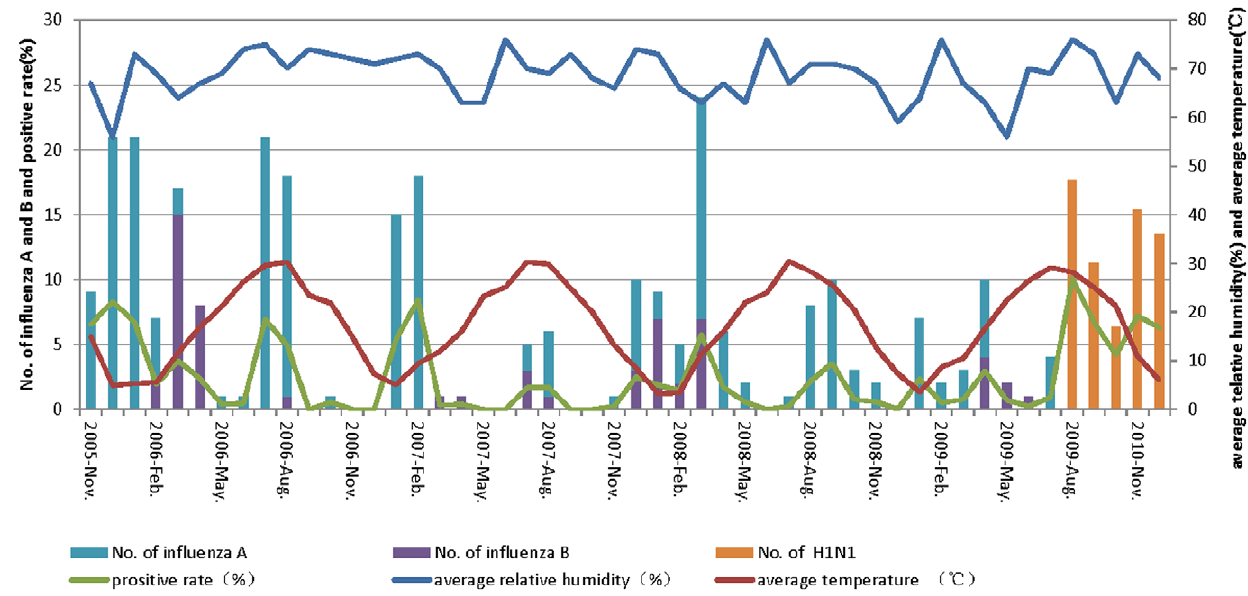
Figure 1. Monthly distribution of number of influenza cases, positive rate, precipitation and mean temperature in Suzhou from Nov 2005 to Dec 2009.